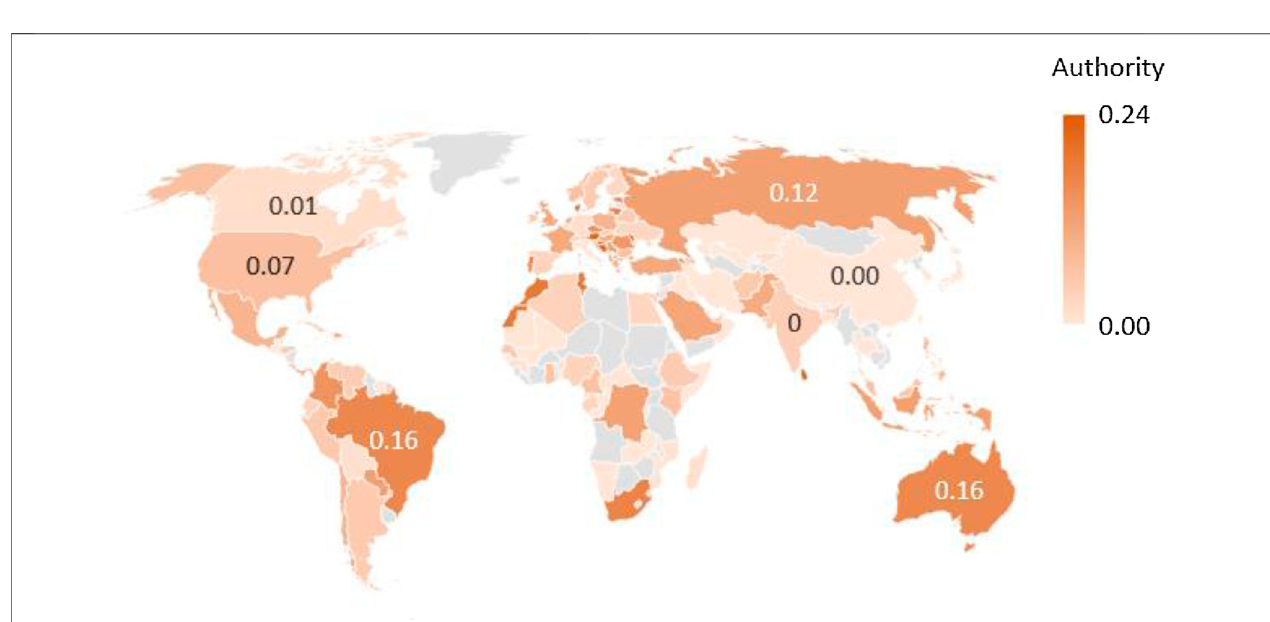
FIGURE 8 | The harmonic closeness of the global COVID-19 pandemic network.